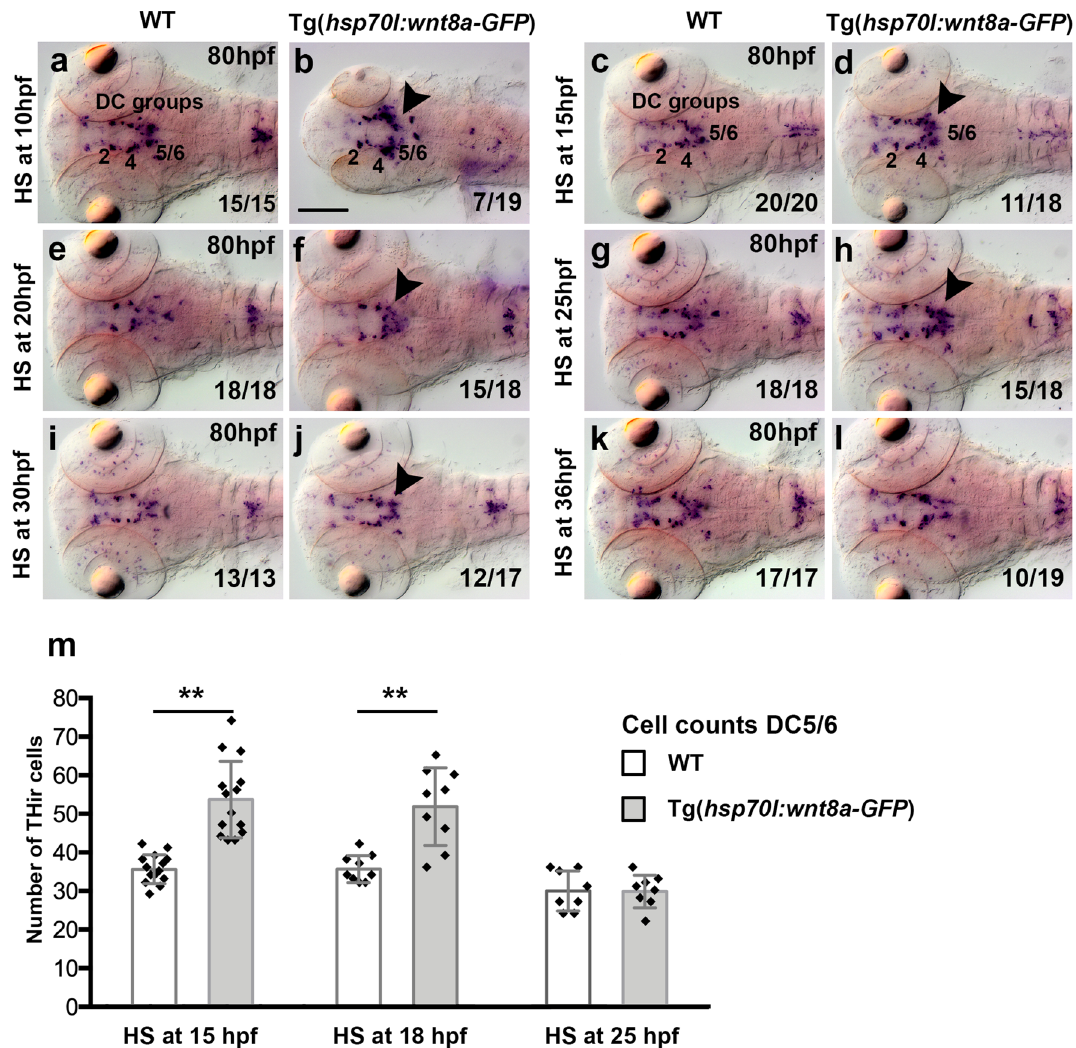
Figure 6. Heat shock induced Wnt8a overexpression affects hypothalamic DC5 and DC6 DA neurons in a stage dependent manner. ( a – l ) Expression of DA neuron marker th as detected by WISH in WT ( a , c , e , g , i , k ) and in heterozygous transgenic Tg( hsp70l:wnt8a-GFP ) siblings ( b , d , f , h , j , l ) subjected to heat-shock treatments as indicated on the left and subsequently fixed at 80 hpf. Dorsal views, images are Z-projections of image stacks. The th expressing DC groups 2, 4, 5 and 6 are indicated in ( a ), ( b ), ( c ) and ( d ). The arrowheads in ( d ), ( f ), ( h ) and ( j ) point to an increase in th expression in DC5 and DC6 DA neuron groups. Scale bar in ( b ) is 100 µm for all images. Numbers N/N in bottom right corner of each image indicate number of representative phenotypes as shown in image versus total embryos analyzed for this condition. ( m ) A separate experiment was performed for quantification of TH-immunoreactive cells in WT embryos compared to heterozygous transgenic Tg( hsp70l:wnt8a-GFP ) siblings heat shocked as indicated and fixed at 82 hpf. Bar charts show cell count numbers and the mean of TH-immunoreactive cells for each indicated DA neuron groups. Error bars depict standard deviations of the mean. Asterisks indicate significant differences compared to non-transgenic sibling control (**p = 0.001 for 15 hpf and p = 0.0009 for 18 hpf; Mann–Whitney U test; n = 14 for 15 hpf, n = 9 for 18 hpf and n = 8 for 25 hpf. Software: Prism 6.0f. from GraphPad Software on the expression of DA precursor marker genes otpa , sim1a and neurog1 , which are the earliest transcription factors required for DA neurogenesis in the ventral diencephalon and hypothalamus 21,22,37,38 . Upon heat shocks at 15 or 20 hpf, the expression of otpa within the ventral diencephalon and hypothalamus appeared unaffected by Wnt8a overexpression when analyzed at 36 hpf (Supplementary Fig. 7a–d, arrowheads). When heat shocks were performed at 15 or 20 hpf, we found a mild increase in the staining intensity of sim1a and neurog1 in the hypothalamus of Tg( hsp70l:wnt8a-GFP ) w34Tg/ + embryos at 36 hpf (Supplementary Fig. 7e–l). Since Neurog1 has been linked to glutamatergic 42 and zebrafish dopaminergic neurogenesis 38 , and since Otp-dependent DA neu- rons all have glutamate as second transmitter 43 , the increase in neurog1 may correlate with an increase in DA progenitors in this region. This further supports that Wnt/β-catenin signaling acts on progenitors. To determine whether the effect of Wnt8a overexpression may be selective for DA neurons, or whether also other neuronal